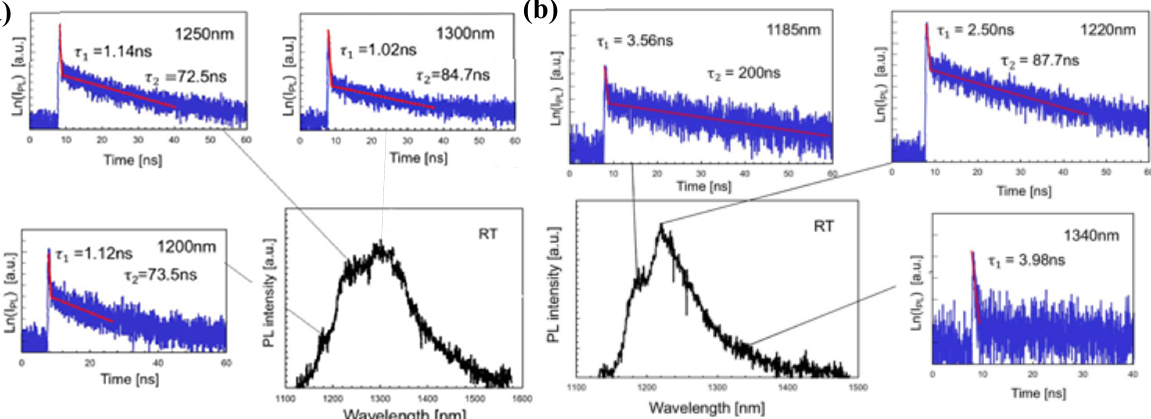
Figure 6. ( a ) µ -PL spectra and decay curves of the QD films prepared for 20 min on a flat substrate. The vertical axes of the decay curves are the natural logarithm of PL intensity. ( b ) µ -PL spectra and decay curves of the QDs films prepared for 7 d on a template. The vertical axes of the decay curves are the natural logarithm of PL intensity [47]. Copyright 2020, Japanese Journal of Applied Physics